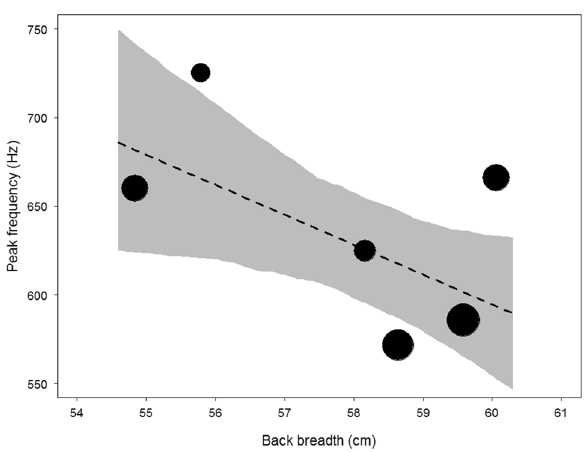
Figure 2. Relationship between body size (back breadth) and peak frequency of chest beats. The area of the circles represents sample size ( N = 36). The dashed line is the fitted model after controlling for age and the shaded area is its 95% confidence